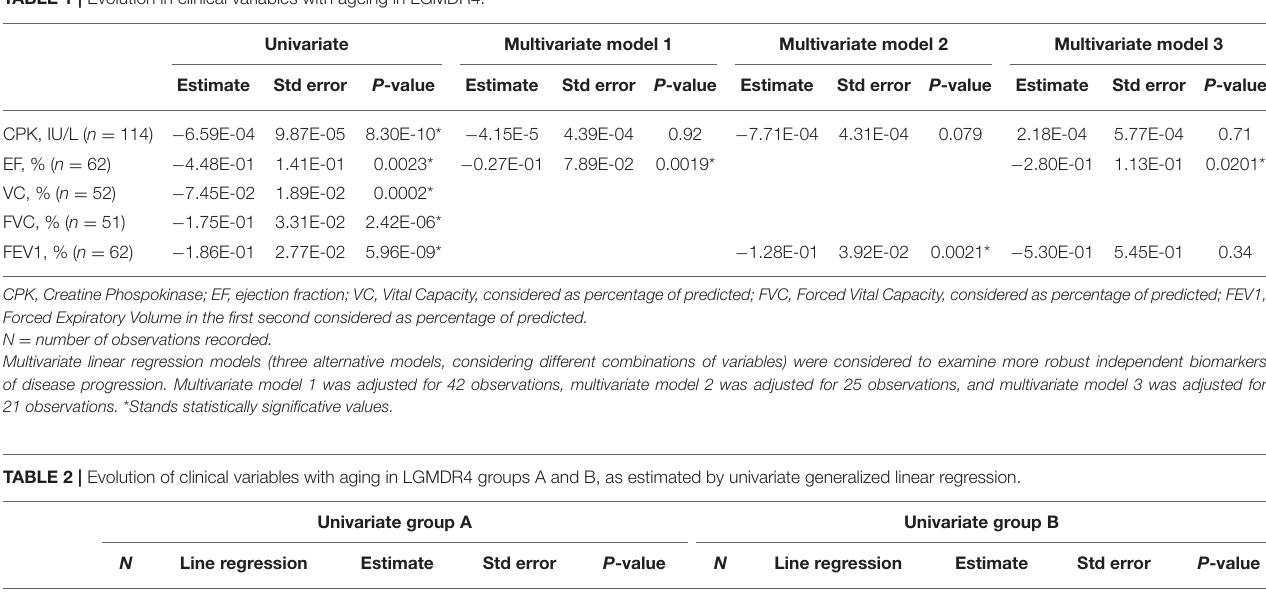
FIGURE 1 | patients, p = 3.40E-02 group A and p = 1.2E-3 group B). Third line: evolution of FEV1 in all patients and in groups A and B over the years: on the Y axis, FEV1 values expressed as percentage; on the X axis, age expressed in years ( p -value 5.96e-9 total patients, p = 3E-10 group A and p = 0.01 group B). Fourth line: evolution of FVC in all patients and in groups A and B over the years: on the Y axis, FVC values expressed as percentage of predicted value; on the X axis, age expressed in years ( p -value 2.42e-6 total patients, p = 5.01E-10 group A and p = 0.20 group B). Fifth line: evolution of VC in all patients and in groups A and B over the years: on the Y axis, VC values expressed as percentage of predicted value; on the X axis, age expressed in years ( p = 0.0002 total patients, p = 2.1E-3 group A and p = 5.7E-7 group B).